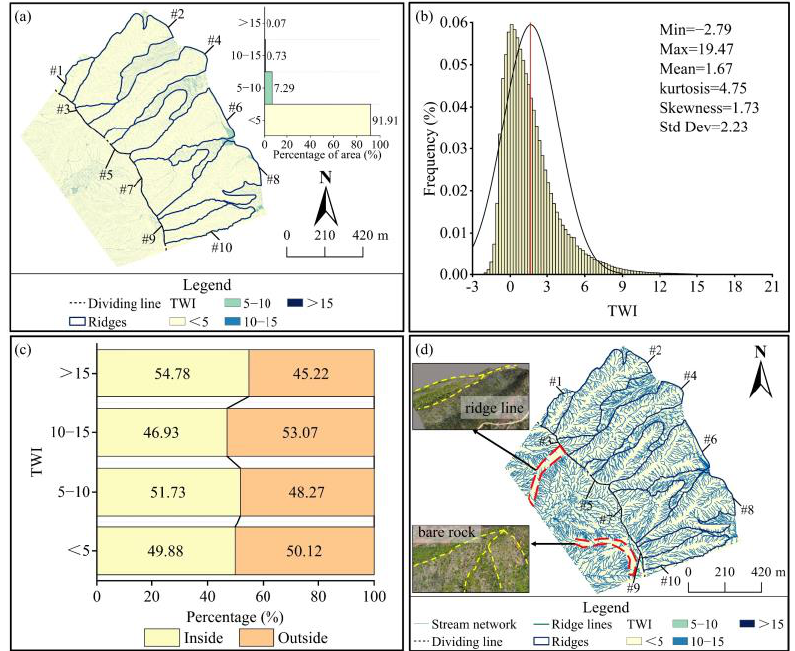
Figure 16. ( a ) TWI classification results, ( b ) TWI frequency statistics, ( c ) TWI area percentage accumulation statistics results inside and outside, and ( d ) TWI combined with river network and ridge lines analysis results. Table 10. Statistical results of the proportions of the inside and outside TWI areas of the pit rim structure.